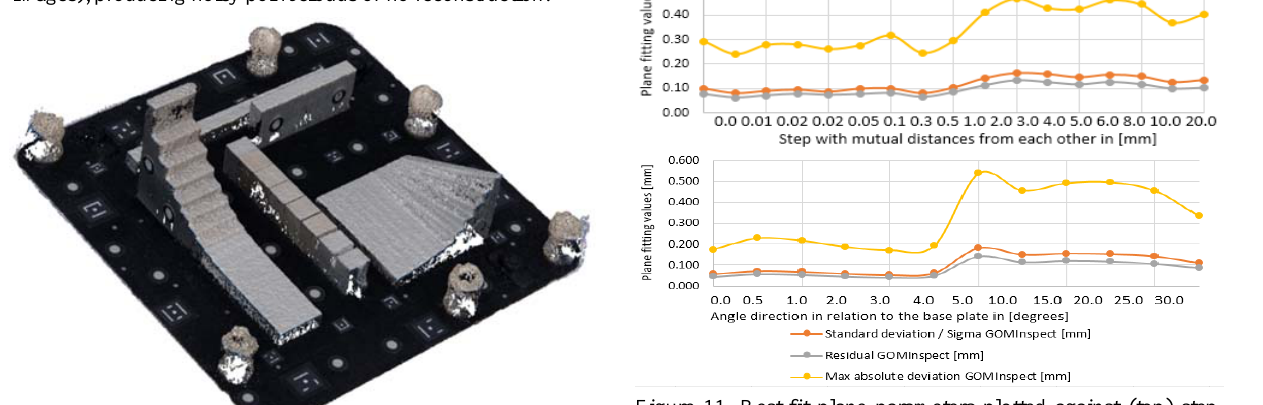
Figure 11. Best-fit plane parameters plotted against (top) step heights and (bottom) angle directions in relation to the baseplate of the Metric Test Object. When comparing standard deviation, residuals and maximum absolute deviation for both datasets, some revealing trends can be observed. Values of the seven steps closer to the base plate show an average stdev of 0.09 and maximum of 0.14 mm, whereas the top eight steps show higher values of stdev 0.14 mm and max 0.41 mm (Fig. 11). A similar trend can be observed for angle direction in relation to the baseplate: angles between 0° and 4° show an average stdev of 0.06 mm and max 0.24 mm, whilst angles between 5° and 30° have an average stdev of 0.14 mm and max 0.45 mm. This leads to the conclusion that elements closer to the baseplate were imaged with more accuracy, probably elements suffered from less sharpness in the